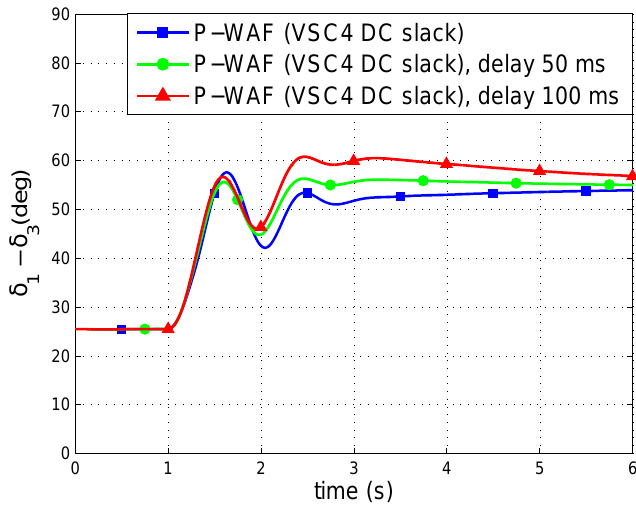
Figure 21. Generator angle